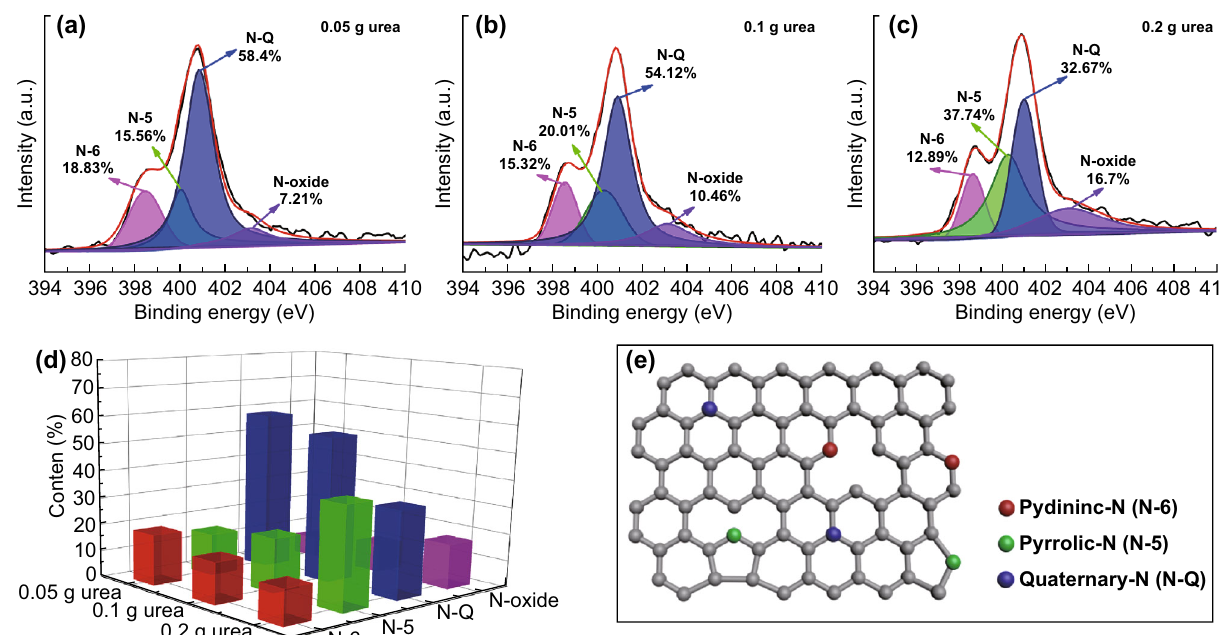
Fig. 6 N 1 s fine spectra of TiO 2 /N–C NFs with a 0.05 g, b 0.1 g, and c 0.2 g of added urea. d Histogram of ratio of different N species in various TiO 2 /N–C NF samples. e Schematic of structural binding conditions of nitrogen Table 1 Nitrogen content of samples to which different amounts of urea were